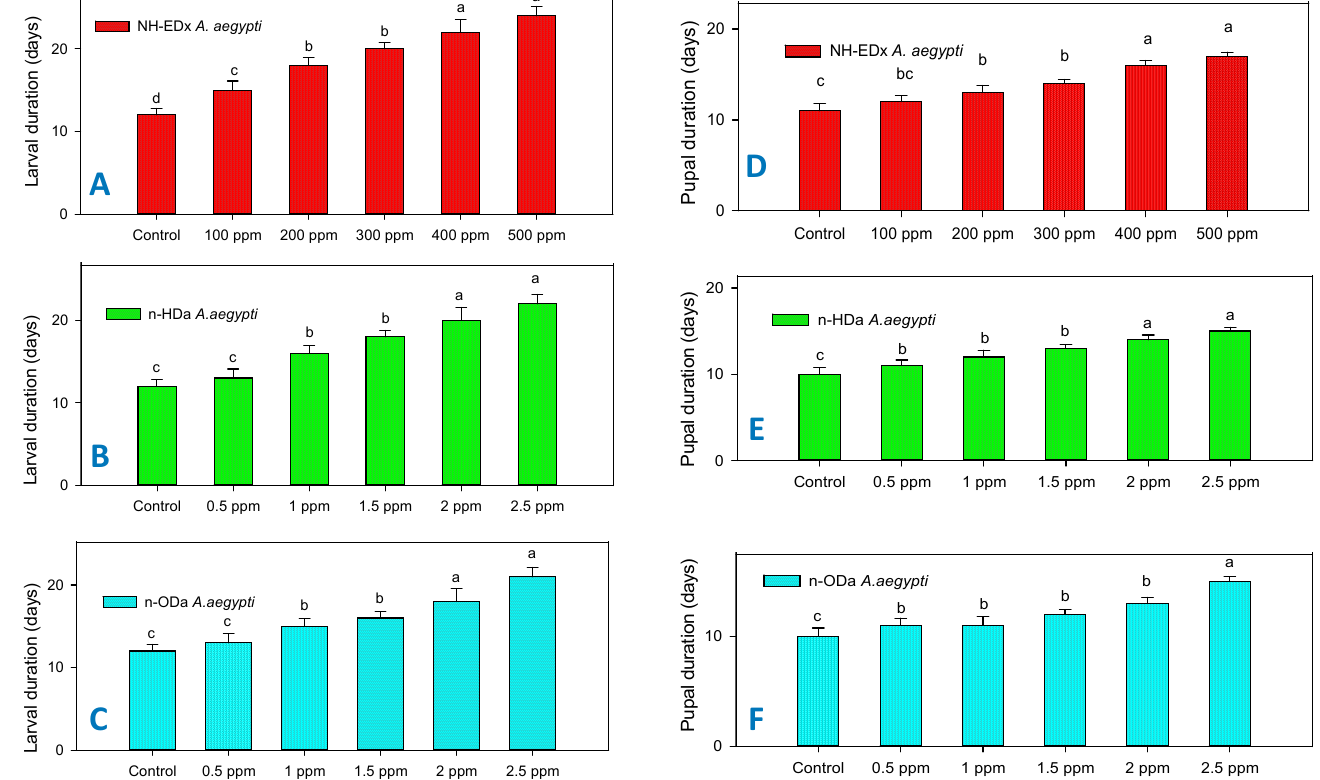
Figure 5. Developmental time in days for A. aegypti larvae after treatment with NH-EDx ( A ), n -HDa ( B ) and n -ODa ( C ) and for A. aegypti pupae after treatment with NH-EDx ( D ), n -HDa ( E ), and n -ODa ( F ), respectively. Means ( ± SEM) followed by the same letters above bars indicate no significant difference ( p ≤ 0.05) according to a Tukey’s test. Correspondingly, the effect on adult longevity (male and female) was also found to be profound in S. litura larvae treated with 500 ppm NH-EDx (F 4,20 = 18.32, p ≤ 0.001) (Figure 6A), 2.5 ppm n -HDa (F 4,20 = 13.45, p ≤ 0.001) (Figure 6B) and 2.5 ppm n -ODa (F 4,20 = 15.77, p ≤ 0.001) (Figure 6C). Likewise, the longevity of adults in A. aegypti